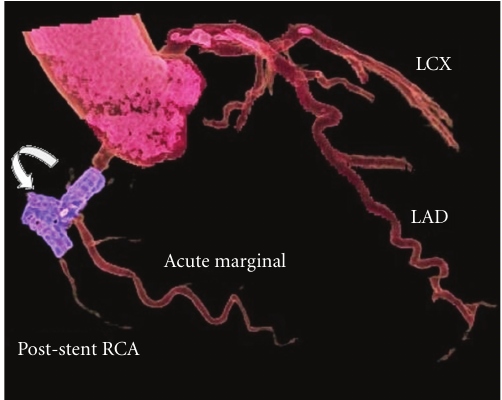
Figure 4: Volume-rendered image showing fractured RCA stent perforating the RCA (curved arrow), followed by faint poststent opacification of the RCA. Good opacification of LAD, LCX, and the acute marginal branch of the RCA is